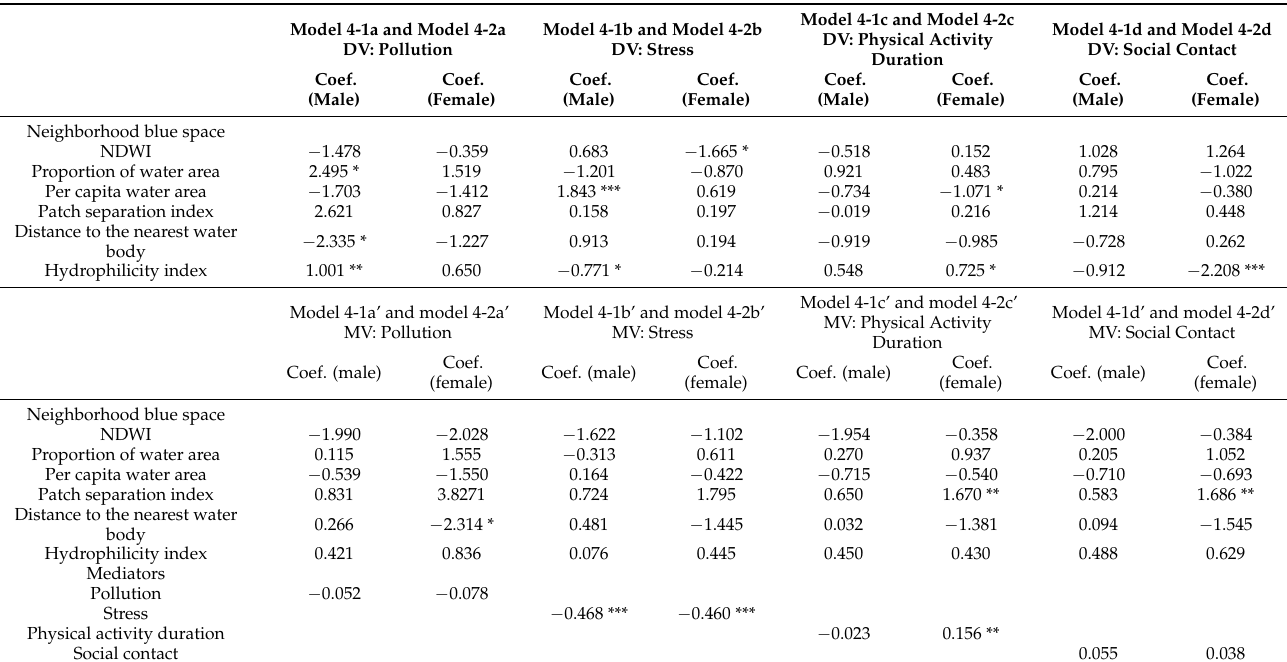
Table 7. Associations between neighborhood blue space, mediators, and SRH in gender